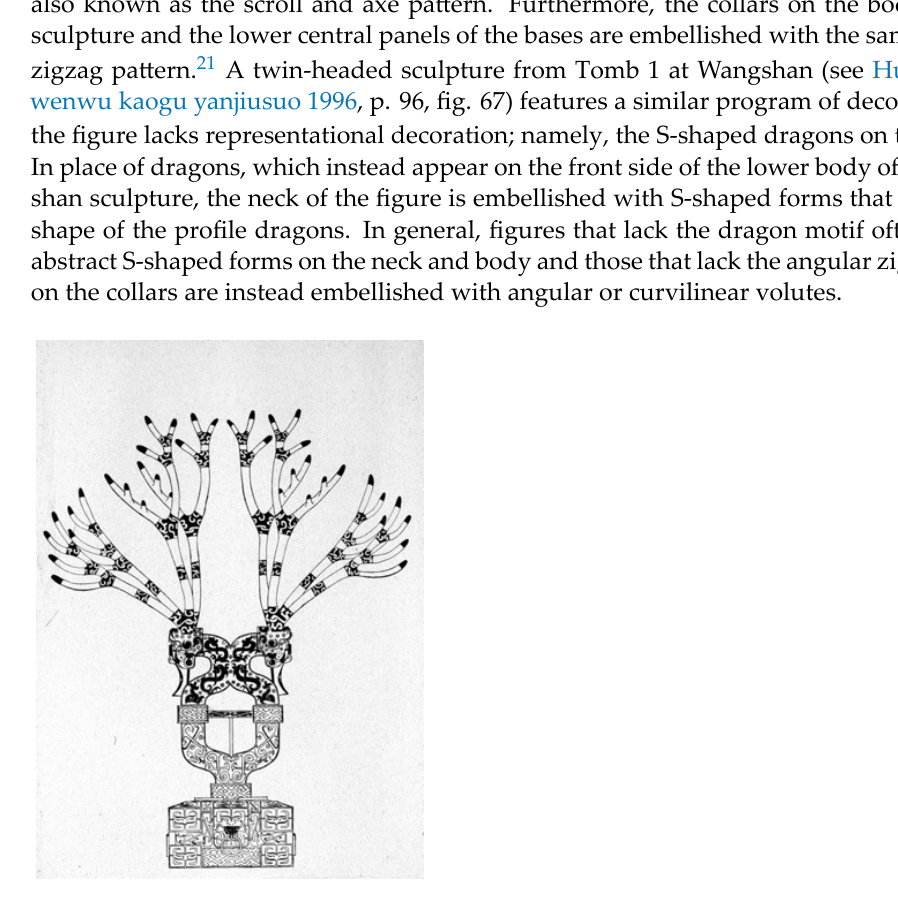
Figure 3. Line drawing of addorsed antlered and tongued tomb sculpture made from lacquered wood and excavated from Tomb 1 at Tianxingguan, Jiangling County, Hubei Province. From Hubei sheng Jingzhou diqu bowuguan (1982, p. 104, fig. 28).